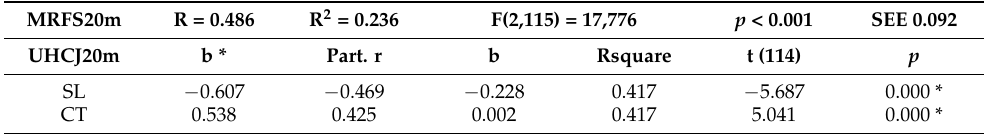
Table 6. Results of stepwise forward regression analysis of the set of kinematic parameters of the UHCJ20m test and the results in the MRFS20m